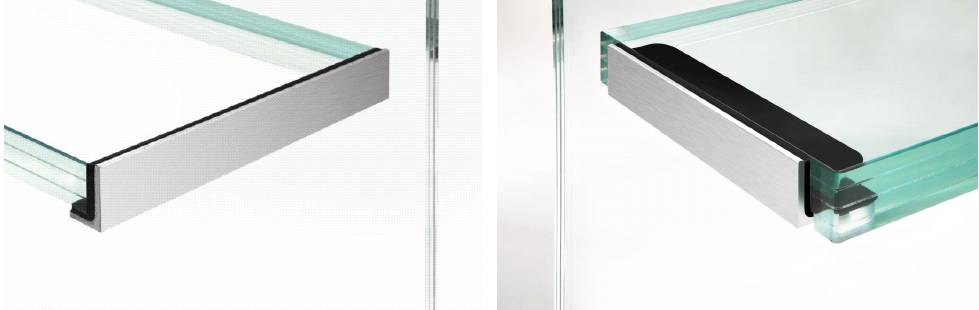
Fig. 6 Examples for connections between glass treads and glass